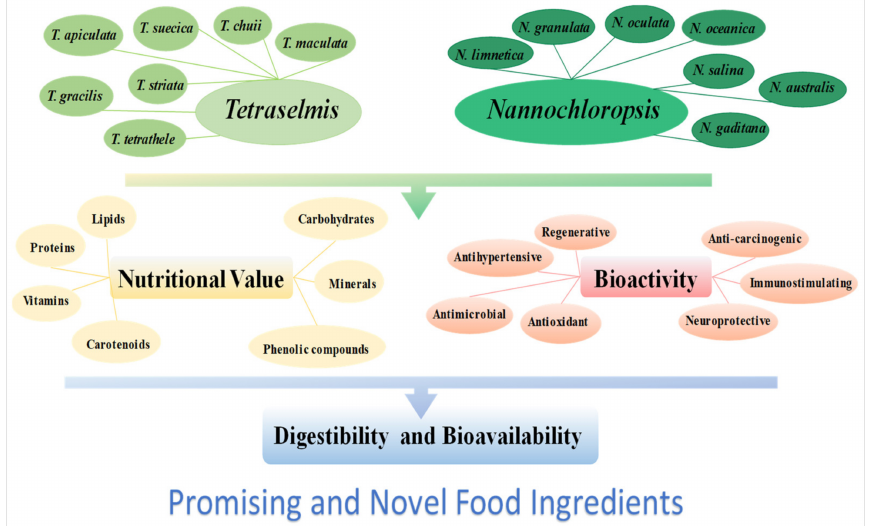
Figure 1. Overview of the nutritional value and bioactivities demonstrated for microalgae Tetraselmis sp. and Nannochloropsis sp.